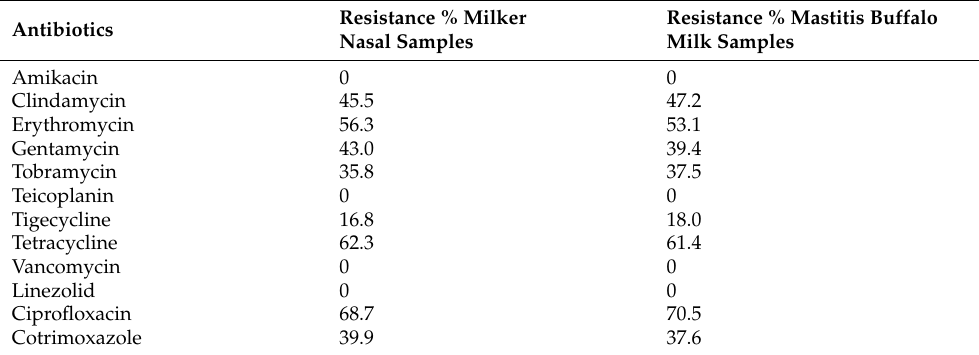
Table 5. Antibiotic resistance profile of Staphylococcus isolated from mastitis buffalo milk samples and milker’s nasal swab